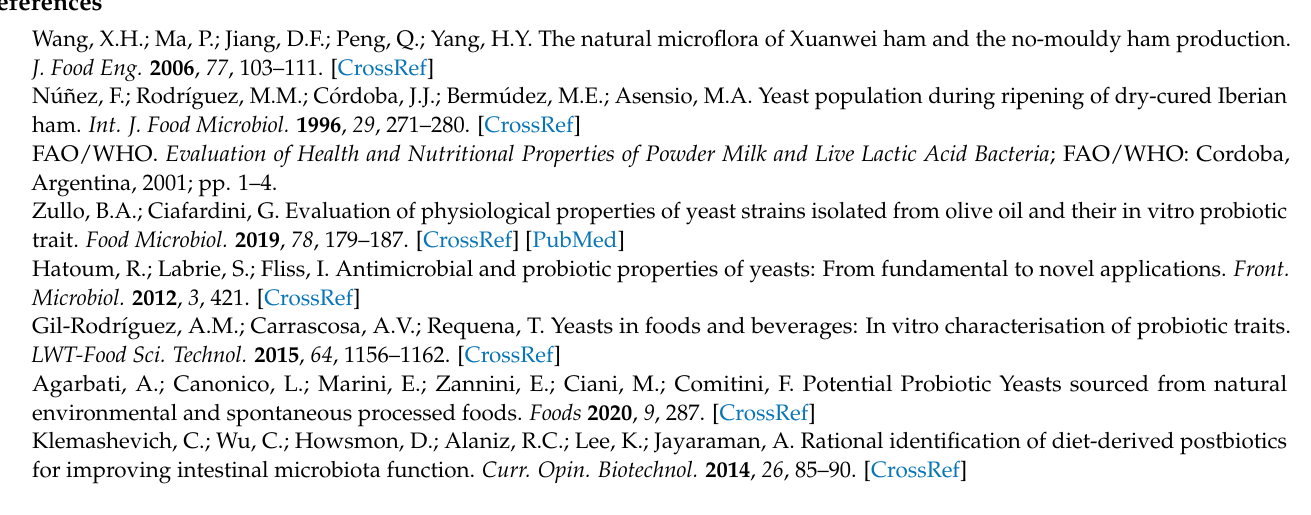
Table S2: Sequence composition and properties in the AP-D10